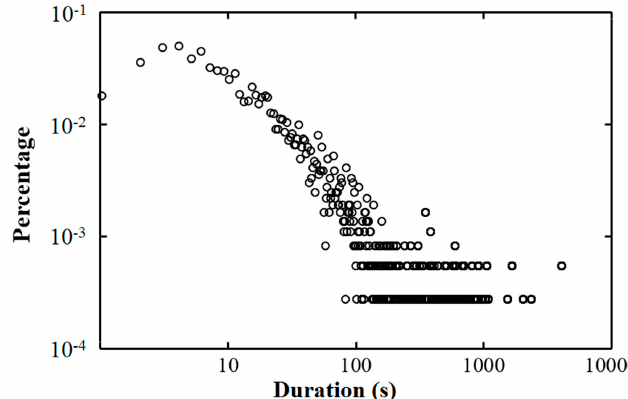
Figure 2. Association between the duration of close contact and the percentage of contacts.